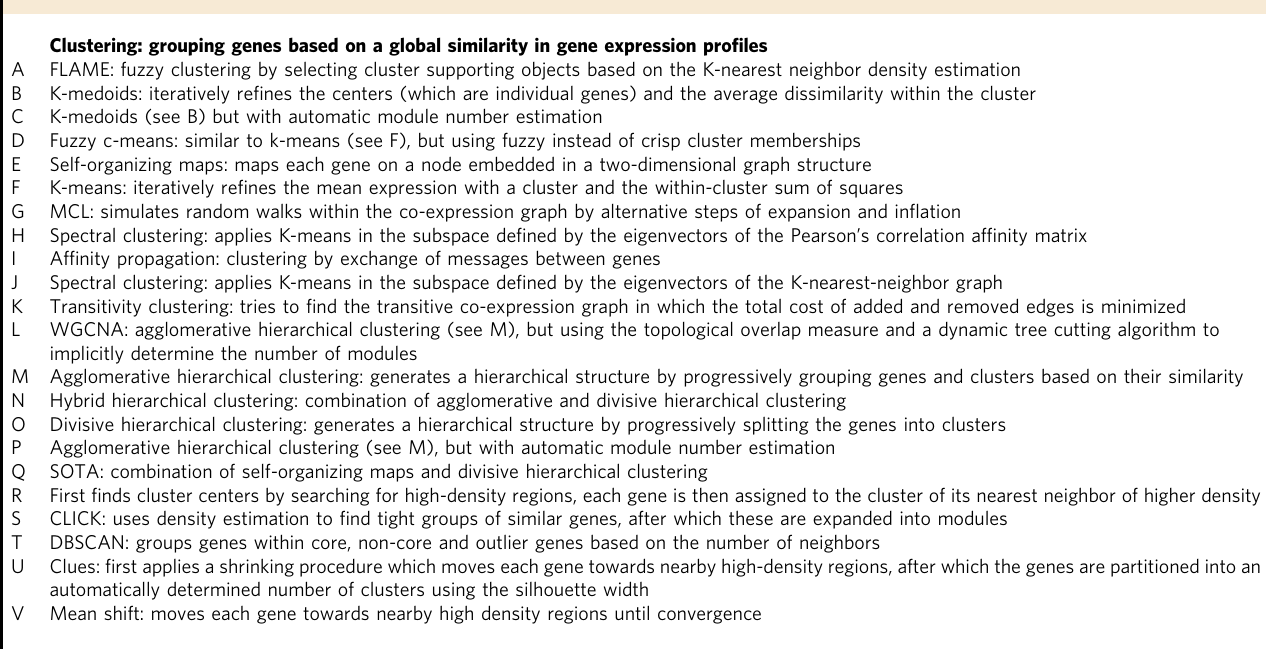
Table 1 Module detection methods evaluated in this